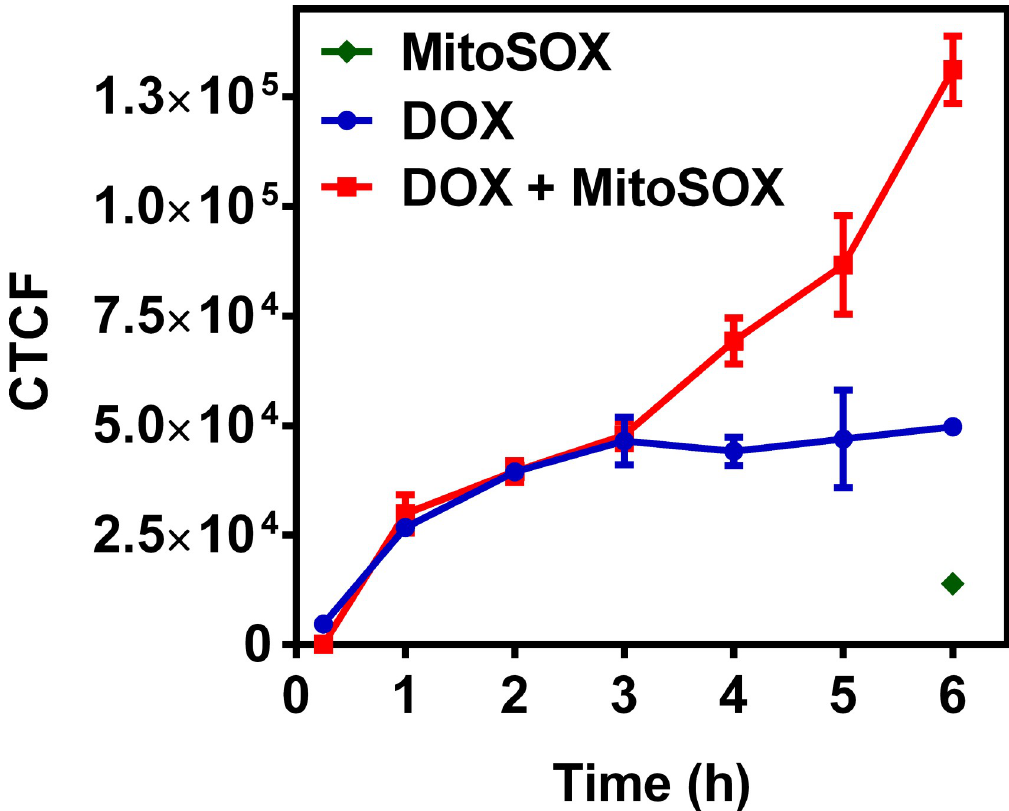
Fig 8. DOX induced superoxide production in rat cardiomyocytes cells. H9c2 cells were treated with DOX (1 μ g/mL) for 60 min at 37˚C, extracellular space was rinsed with PBS (2 times), replaced with media, incubated with MitoSox (0.5 μ M) at 37˚C for 15 min, and intracellular uptake was analyzed using fluorescence imaging. Corrected Total Cell Fluorescence (CTCF) = Integrated Density–(Area of selected cell × Mean fluorescence of background readings); (mean ± SEM; p > 0.01).